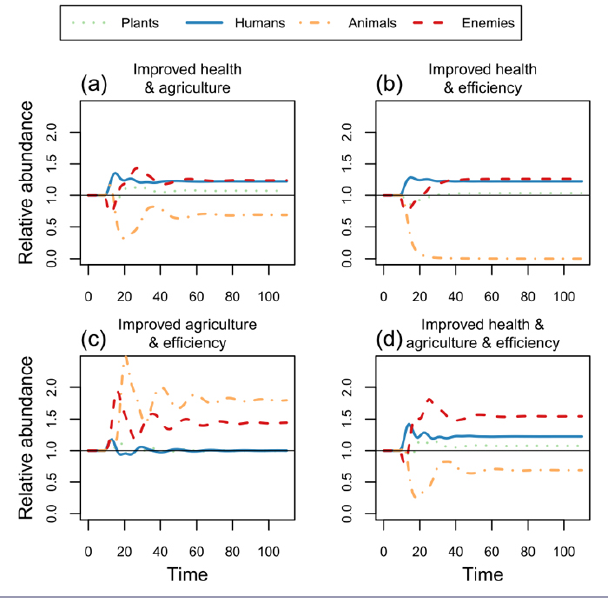
Fig. 2 . Effects of combinations of improvements in health, Fig. 3 . Effects of health improvements (a), or both health agriculture, and resource use efficiency on the abundances of improvements and increased resource consumption (b), on humans, plant and animal resources, and natural enemies. All human birth rate ( c f P + c f A), death rate ( c E + m ), and ph ph ah ah he h state variables were at equilibrium from time 0 to 10, and are relative abundance. All state variables were at equilibrium from shown relative to these equilibrium values. Initial parameter time 0 to 10, and human abundance is shown relative to its values satisfied the feasibility conditions: c = 2, c = 4, m = initial equilibrium value. Initial parameter values satisfied the he pa h 0.25, c = c = f = f = f = f = m = m = r = K = 1. At feasibility conditions: c = 2, c = 4, m = 0.25, c = c = f = ah ph ah he pa ph a e he pa h ah ph ah time 10, and thereafter, relevant parameters were changed by f = f = f = m = m = r = K = 1. At time 10, and thereafter, he pa ph a e 10% to consider the effects of combinations of improvements. relevant parameters were changed by 40% to consider health Parameters were changed as in Figure 1. For example, improvements (i.e., decrease c from 2 to 1.2 and increase me he improvements in agriculture and efficiency (c) consisted of a from 1.0 to 1.4) (a), or both health improvements and increases 10% increase in four parameters ( r, K, f , f ) from 1.0 to 1.1, in consumption (i.e., decrease c from 2 to 1.2; increase c ah ph he ah while other parameters remained constant values. from 1.0 to 1.4; increase both c and c from 1.0 to 1.4) ah ph